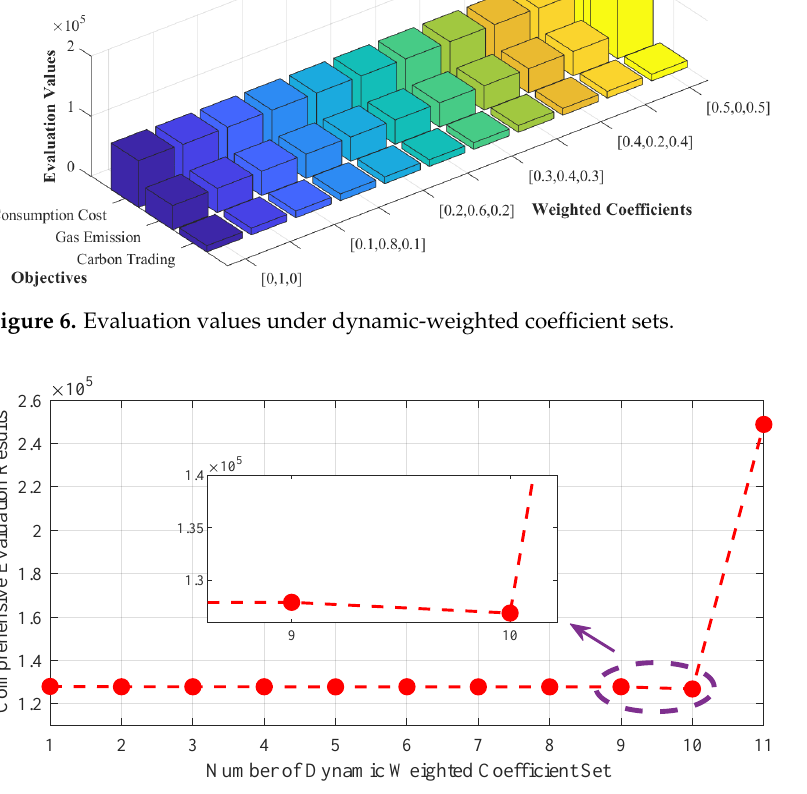
Figure 7. Comprehensive evaluation